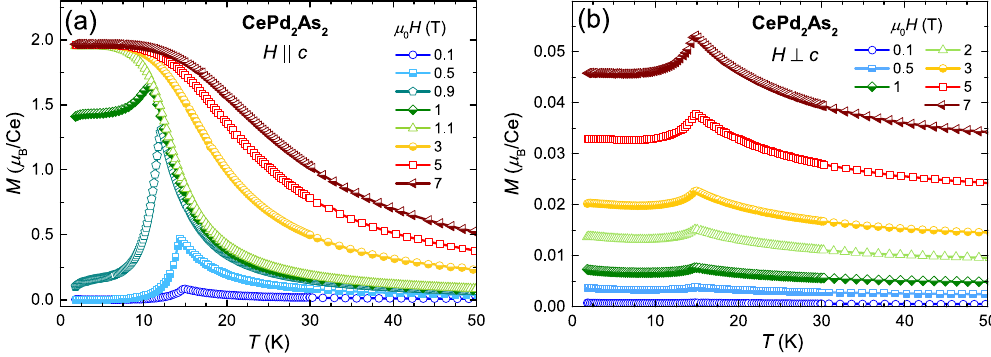
Figure 3. Temperature dependence of the magnetisation M ( T ) measured under various magnetic fields applied ( a ) parallel and ( b ) perpendicular to the crystallographic c -axis.